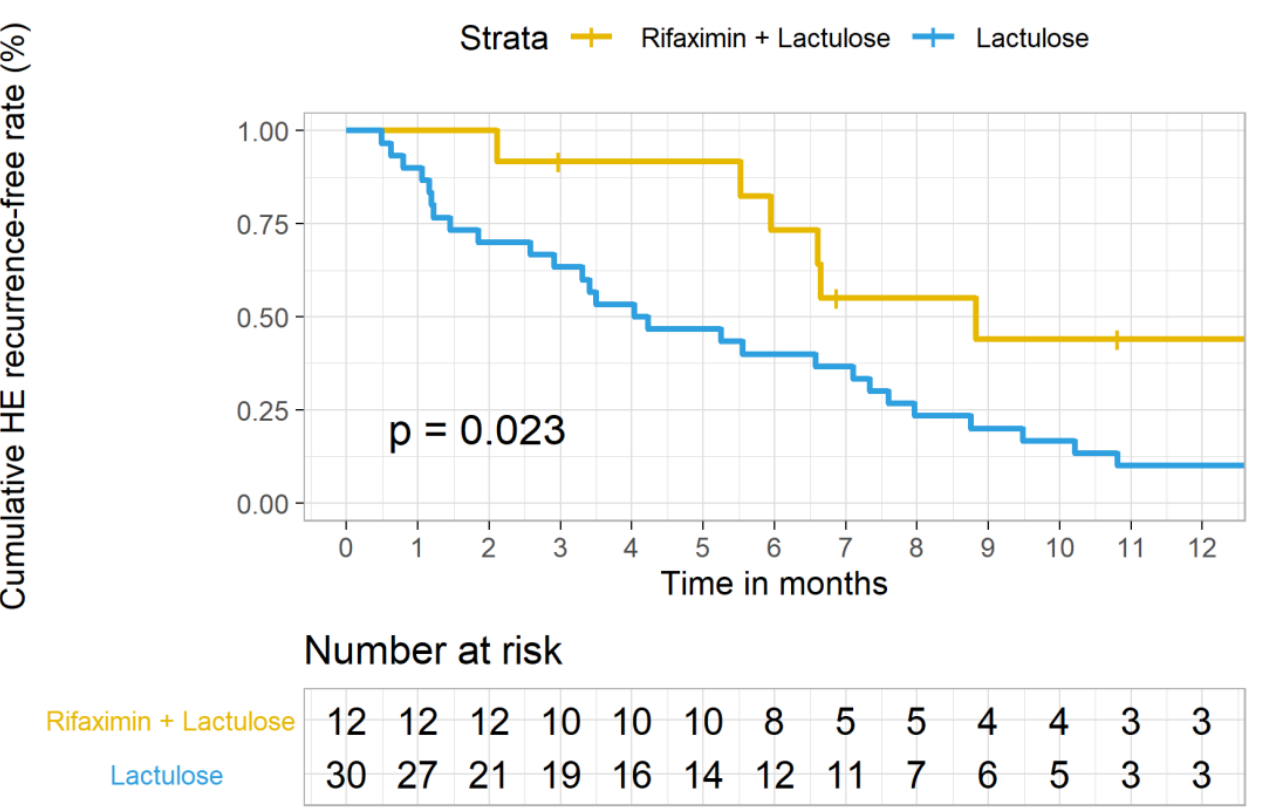
Figure 2. Kaplan–Meier estimates of the efficacy of rifaximin add-on to lactulose (group 1) vs. lactulose monotherapy (group Figure 2. Kaplan – Meier estimates of the efficacy of rifaximin add-on to lactulose (group 1) vs. 2) in preventing HE recurrence within 12 months among patients with cirrhosis complicated by hepatic encephalopathy. lactulose monotherapy (group 2) in preventing HE recurrence within 12 months among patients Time to first HE episode within 12 months of follow-up: Log-Rank p = with cirrhosis complicated by hepatic encephalopathy. Time to first HE episode within 12 months of follow-up: Log-Rank p = 0.023.